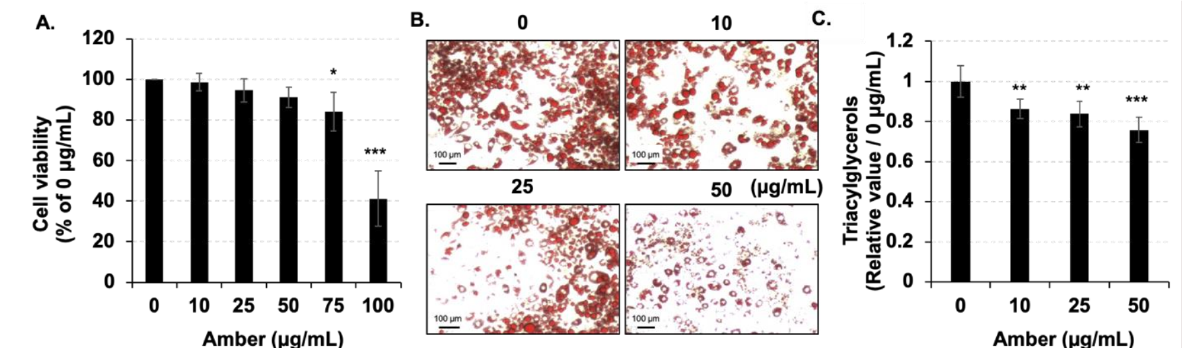
Figure 1. Effects of amber extract on cell viability and lipid accumulation. ( A ) After treatment of 3T3-L1 cells with amber extract (0, 10, 25, and 50 µ g/mL) for 96 h, cell viability was measured using the MTT assay. ( B ) Photographs of lipid droplets in cells stained with Oil Red O stain. ( C ) Triacylglycerol (TAG) levels in the lipid droplets were measured using Oil Red O staining. The results are presented as the mean ± SD; n = 3; * p < 0.05, ** p < 0.01, *** p < 0.001 vs. 0 µ